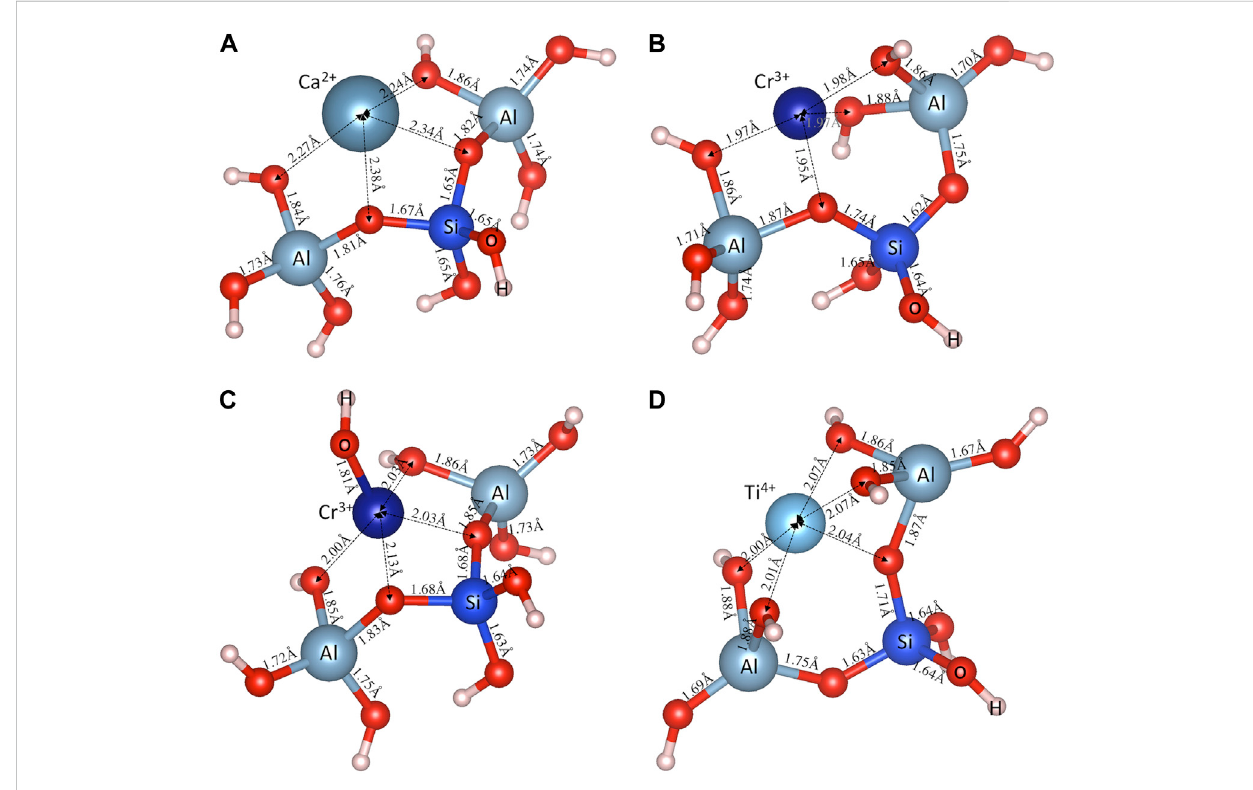
FIGURE 3 DFT-optimized aluminosilicate trimer (i.e., [(OH) 3 -Al-O-Si-O(-(OH) 2 )-Al-(OH) 3 ] − 2 ), charge-balanced by a typical (A) divalent cation (Ca 2+ ), (B) trivalent cation (Cr 3+ ), (C) bivalent cluster ([Cr(OH)] 2+ ), and (D) tetravalent (Ti 4+ ) cation. Also shown are the interatomic bond distances (in Å).